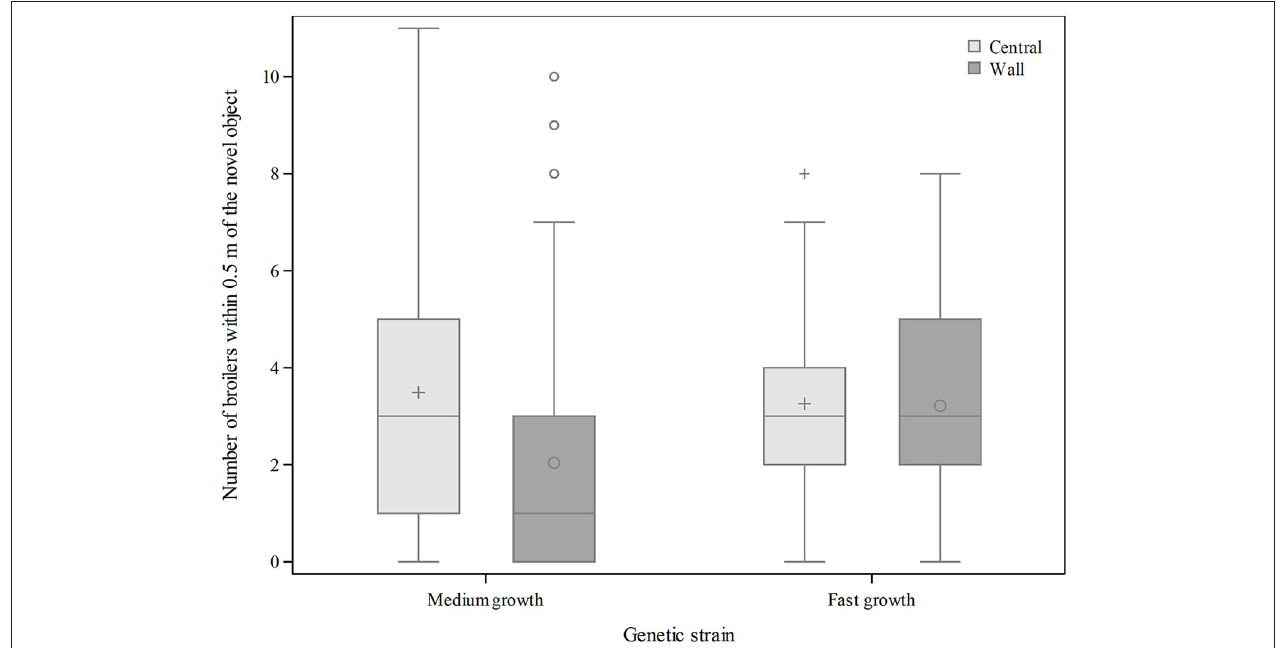
FIGURE 2 | Interaction between the genetic strain and the assessment house location on the number of broilers within 0.5m of the novel object. Boxes show interquartile ranges, and whiskers represent minimum and maximum values. Symbols ( + , ◦ ) inside boxes indicate the mean value, while symbols ( + , ◦ ) outside whiskers represent outliers.